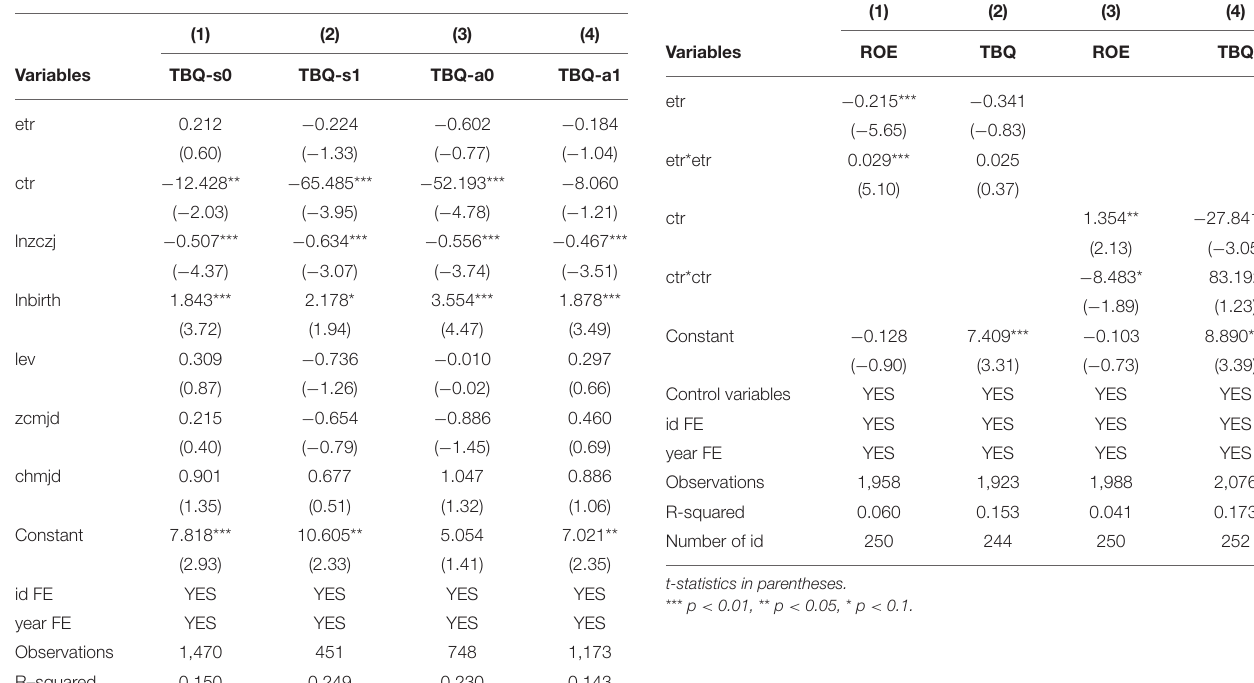
TABLE 7 | Results of heterogeneous regression of long–term financial performance.